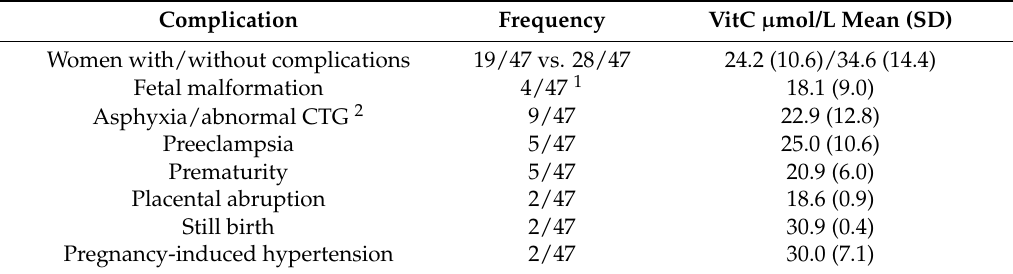
Table 4. The type and distribution of complications in T1DM women ( n = 47). Recorded complications were prematurity, gestational hypertension, asphyxia, malformation, still birth, placental abruption,